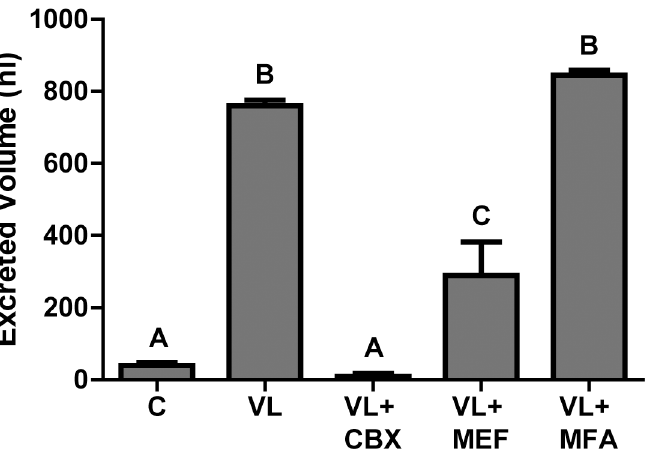
+ CBX = mosquitoes injected with 900 nl of HBS and 1.34 mM carbenoxolone. VL + MEF = mosquitoes injected with 900 nl of HBS and 0.5 mM mefloquine. VL + MFA = mosquitoes injected with 900 nl of HBS and 1.53 mM meclofenamic acid. Letters (A, B or C) indicate statistical differences as determined by a one-way ANOVA and Newman-Keuls post-test (P < 0.05). Values are mean volumes of urine excreted per mosquito after two hours ± SEM. n = 14 for VL, n = 14 for C, n = 8 for VL + CBX, n = 6 for VL + MEF, and n = 6 for VL + MFA.